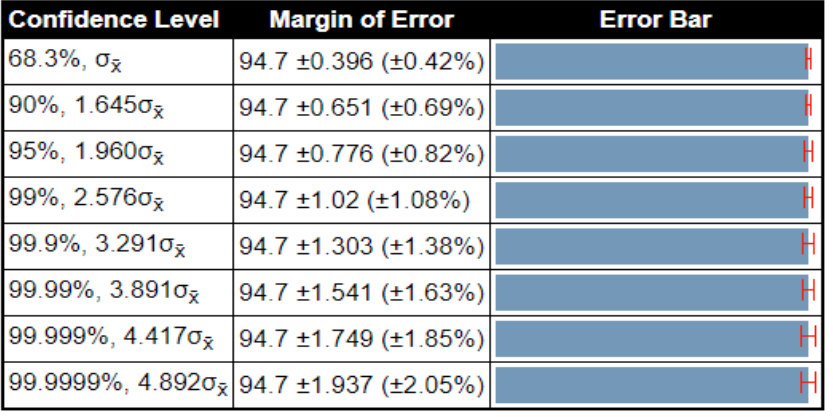
Figure 18. Confidence-interval-based analysis of proposed method on CASIA B dataset.